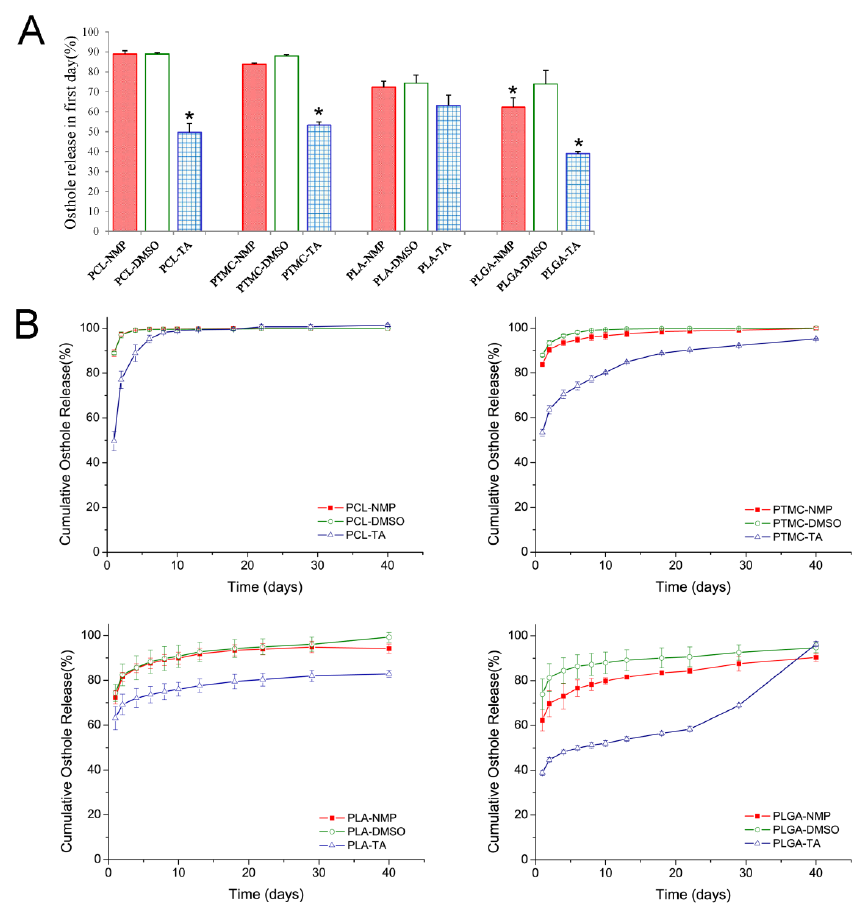
Figure 2. In vitro release of Osthole from ISFIs prepared by different polymers and solvents. ( A ) The burst release e ff ect. ( B ) In vitro release profiles. (mean ± S.D., n = 5). * P < 0.05.